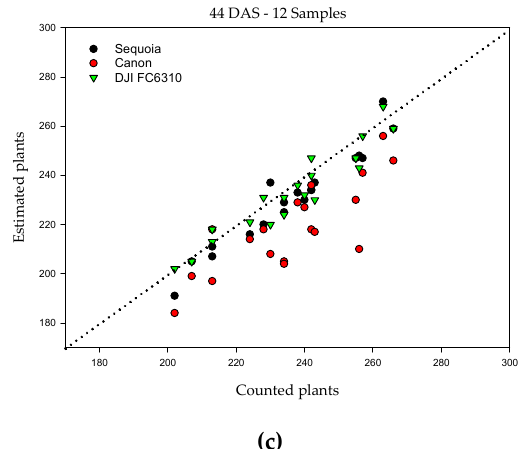
Figure 5. Corn plant count with respect to the sensor and pixel size 44 days after sowing (V5 stage). ( a ) correlation in the count for four samples; ( b ) correlation in the count for eight samples; ( c ) correlation in the count for twelve samples.